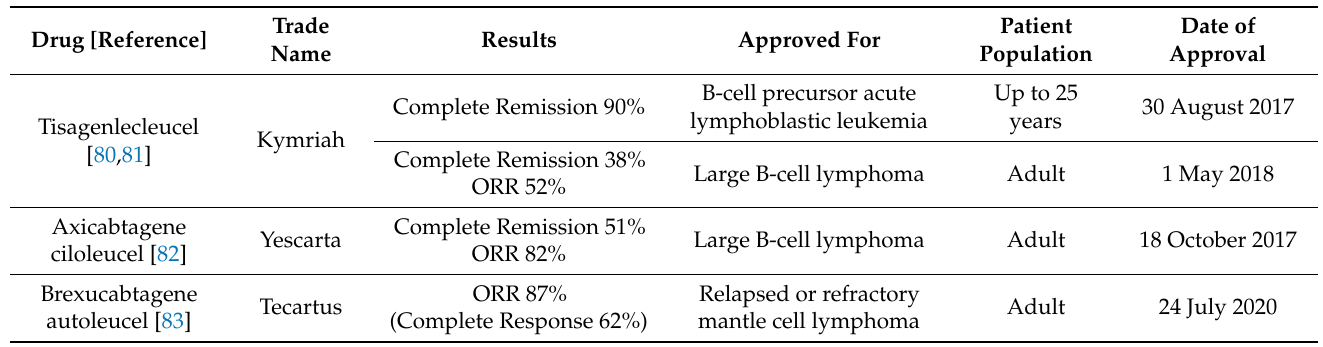
Table 2. Current FDA-approved CAR-T cell